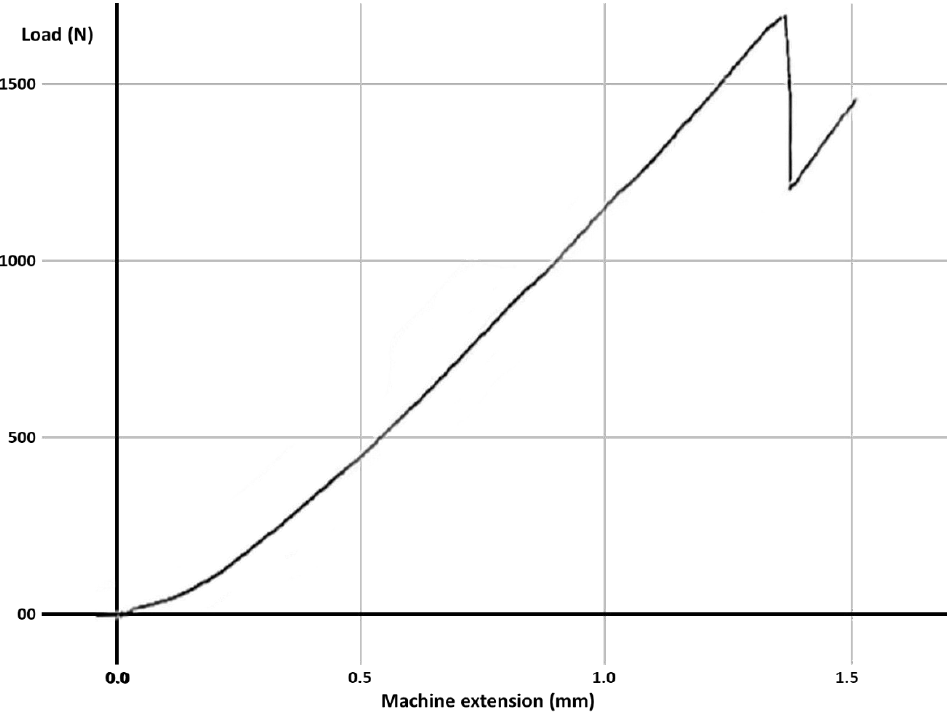
Figure 7. The maximum value of the force at which the most resistant molar from Group F failed.